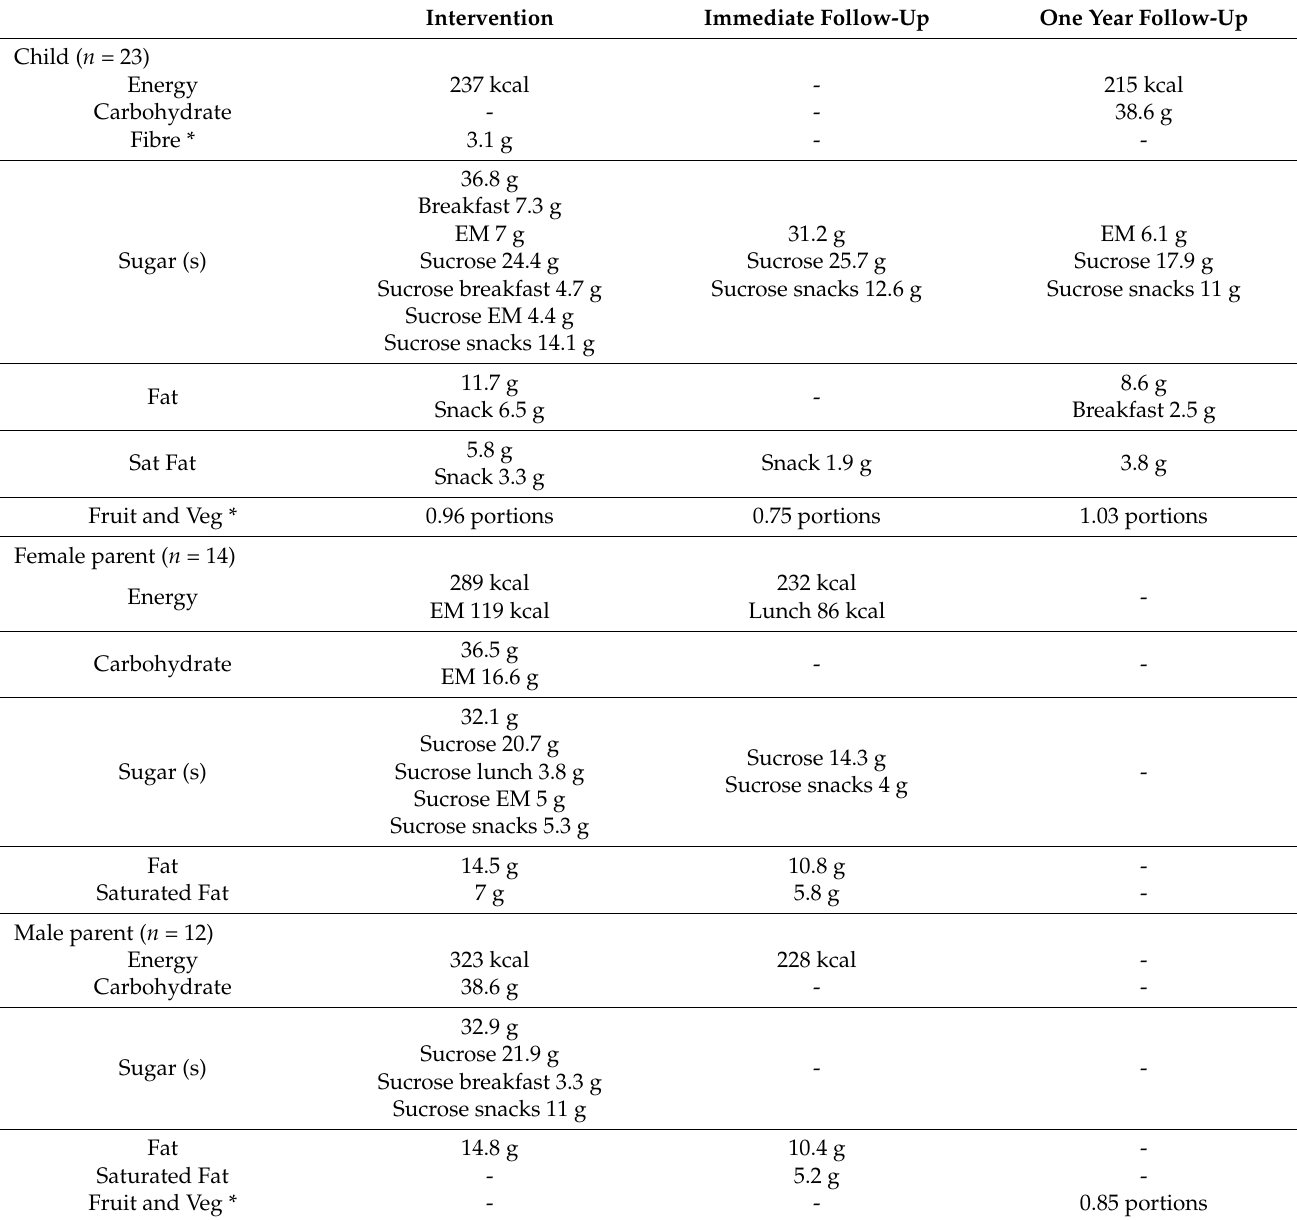
Table 3. Significant reductions only in intake per day relative to baseline for each member of the family (Bonferroni corrected p < 0.05) (breakfast = observed change for breakfast, snack = change observed for snack, lunch = observed change for lunch, EM = change observed for evening meal). One portion of fruit and vegetables = 80 g. Mean (range) number of days data per family for each stage were 13.86 (12–14) for baseline, 13.93 (13–14) for intervention, 14 (14) for immediate follow-up, and 14 (14) for one year follow-up. * represents an